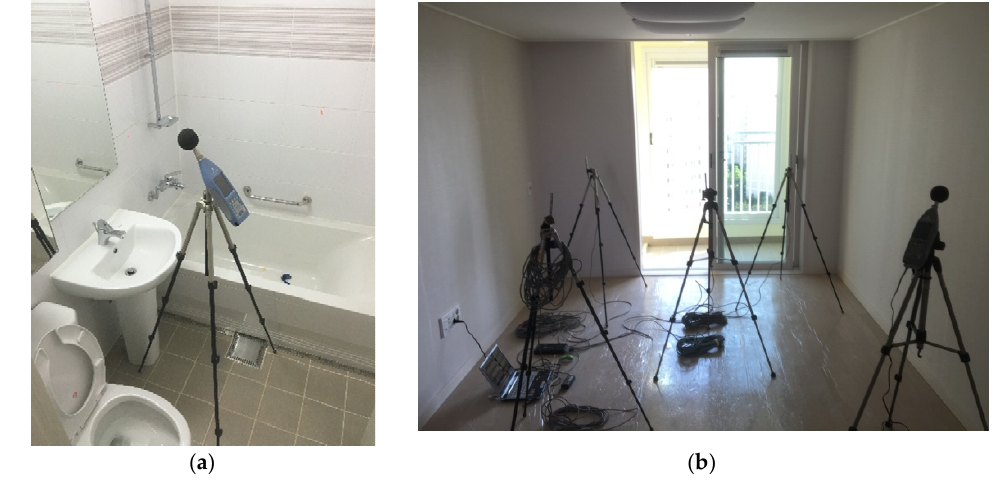
Figure 4. Views of the experimental setups in ( a ) the bathroom and ( b ) the living room.